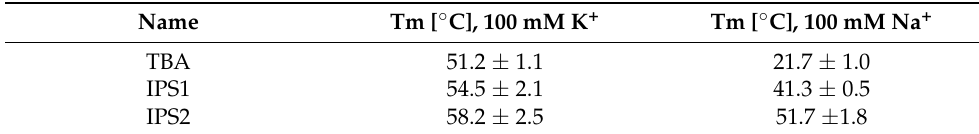
Table 1. Melting temperatures calculated for studied oligonucleotides.